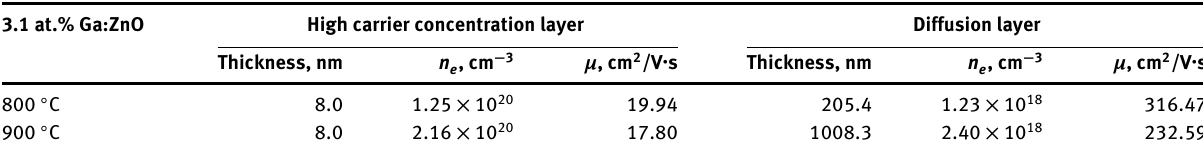
Table 1: Drude-fitting parameters of the two 3.1 at.% samples annealed at 800 ◦ C and 900 ◦ C, respectively. 3.1 at.%